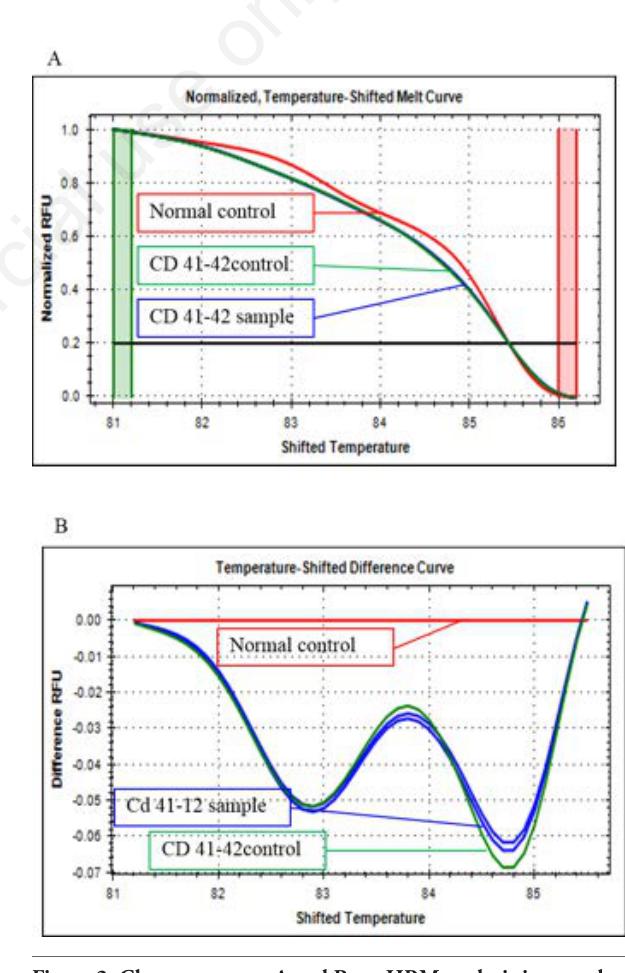
Figure 1. Quantitative real-time PCR image of a case of beta tha- lassemia trait CD41-42 -CTTT mutation tested using C1 primers. The red line represents normal control, green is the CD41-42-CTTT mutation, and blue is an CD 41-42 sample. Chromatogram A is an amplification profile, and B is a melting profile. In B, it is not possible to differentiate the melting pro- files between wild-type and mutant products.